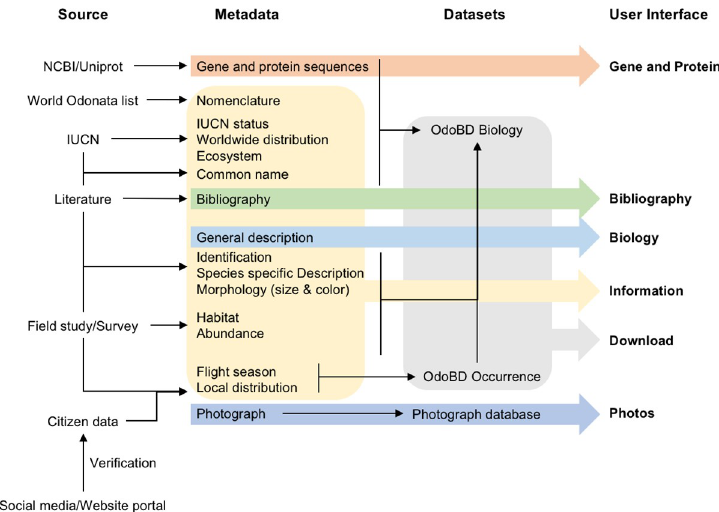
Fig 1. Schematic diagram of the database showing the sources and the structure of the data in relation to the user